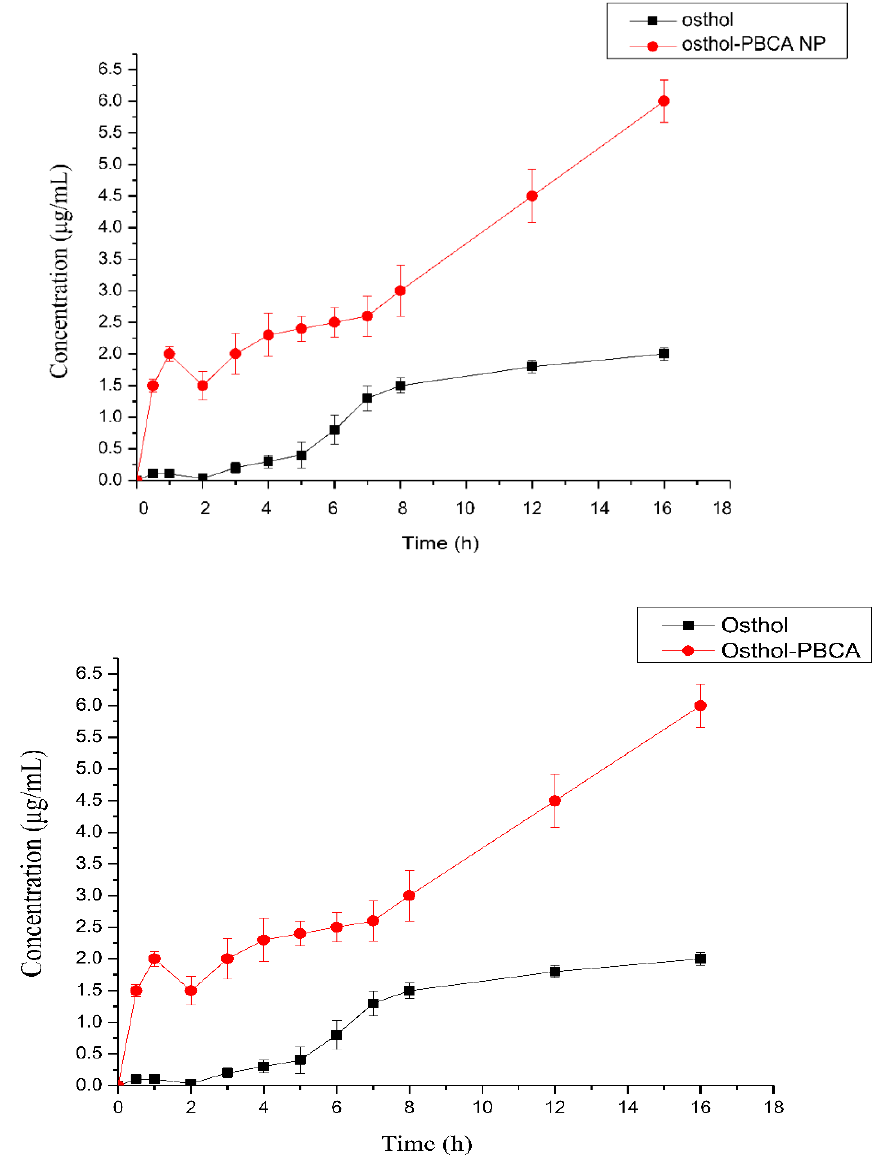
Figure 6. Process of intracellular endocytosis of osthol-PBCA NPs in SH-SY5Y cells. 3.6. The Endocytosis Transport Mechanism of Osthol-PBCA NPs in Cells Endocytosis mechanisms show how cells interact with the environment. Different types of drug endocytosis mechanisms lead to different drug uptake rates. The main mechanisms of endocytosis are clathrin-mediated endocytosis and receptor-independent macropinocytosis. NPs different in size, charge, shape, and core material regulate differ- ent endocytosis processes, and the cell adjusts these pathways to meet its physiological needs. In this study, the cellular uptake mechanism of osthol solution and osthol-PBCA NPs by SH-SY5Y cells was studied using endocytic inhibitors (Figure 7).